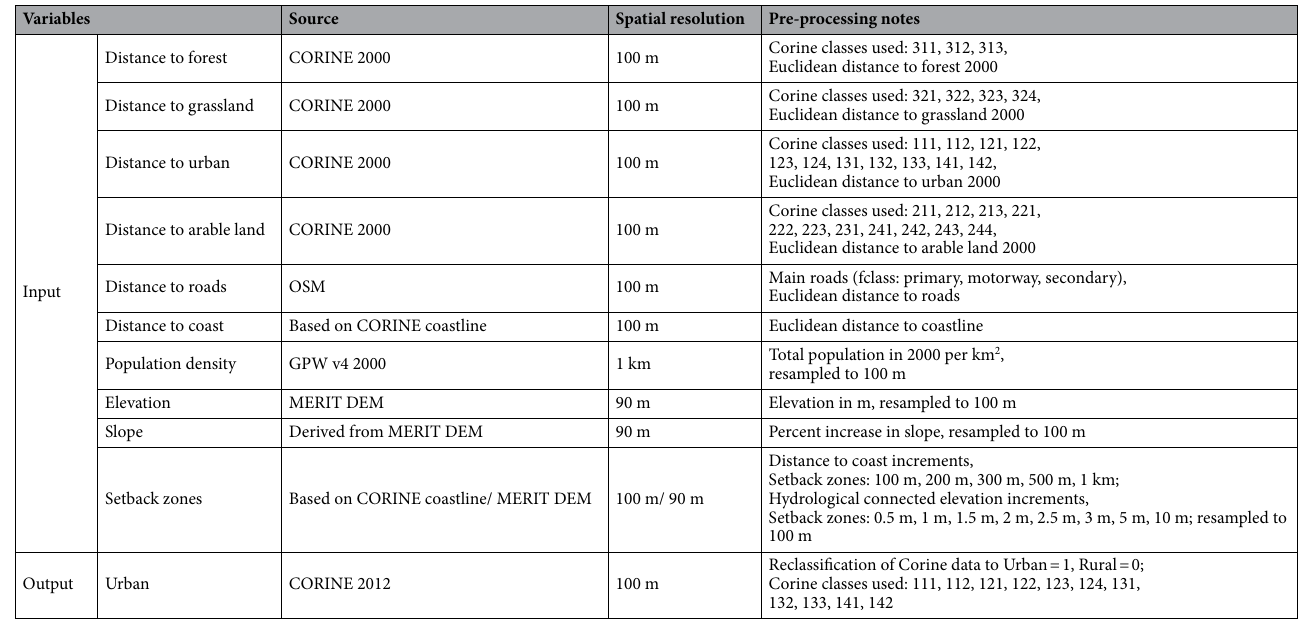
Table 2. Summary of data used for input and output variables of the MLP.